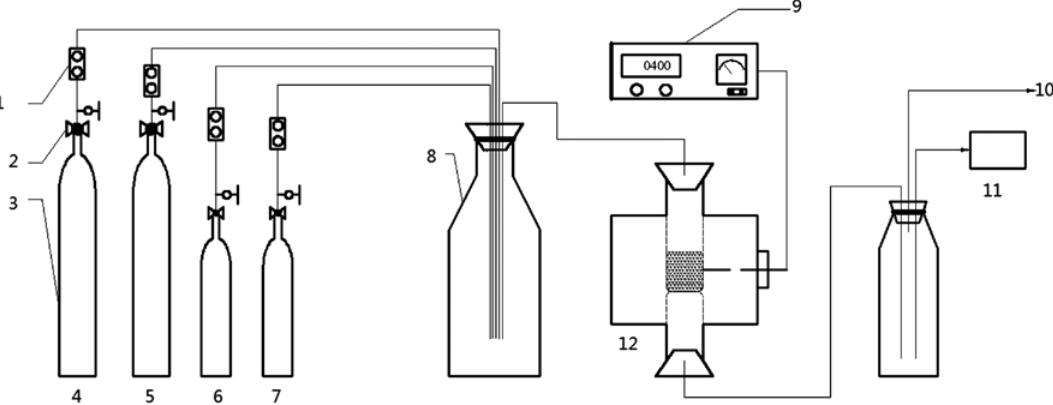
Figure 1: The testing device of catalyst performance: (1) gas flow meter, (2) relief valve, (3) high pressure steel, (4) oxygen, (5) nitrogen, (6) nitrogen monoxide, (7) ammonia, (8) mixed gas cylinders, (9) tube furnace control instrument, (10) gas emission, (11) hand-held gas analyzer, (12) tube